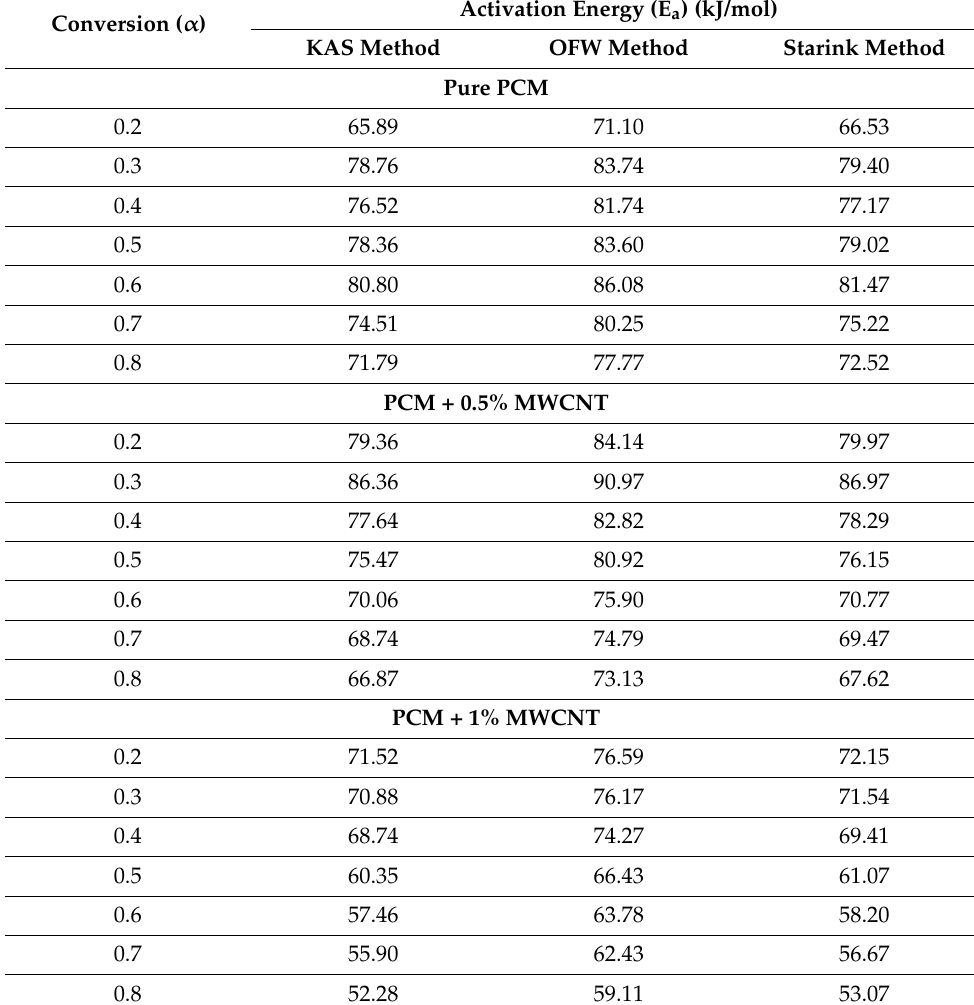
Table 1. Activation energy values of various PCM samples for developed kinetic